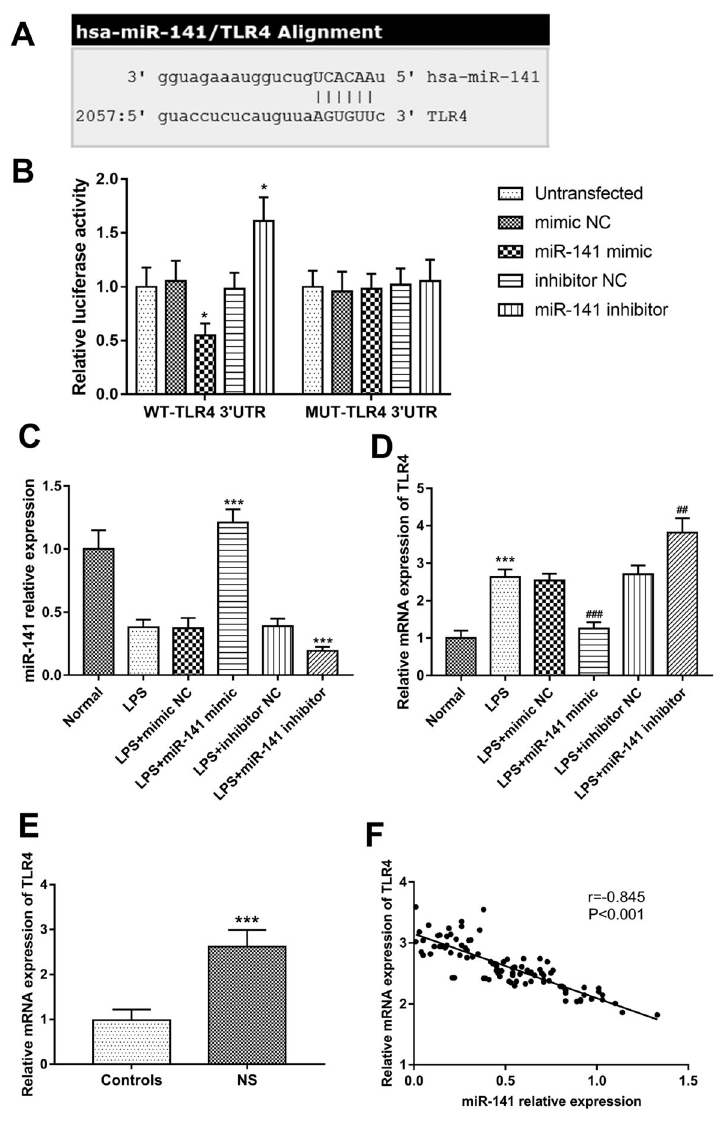
Figure 3. miR-141 directly regulated TLR4 in lipopolysaccharide (LPS)-treated monocytes. A , The putative binding site of miR-141 at the 3 0 -UTR of TLR4. B , The relative luciferase activity in the WT group was inhibited by the overexpression of miR-141, but was enhanced by the inhibition of miR-141 (WT: wild type; MUT: mutant type; *P o 0.05). C , The expression of miR-141 was successfully upregulated by miR-141 mimic, and was downregulated by miR-141 inhibitor (***P o 0.001). D , The promoted expression of TLR4 induced by LPS was inhibited by the overexpression of miR-141, but was further enhanced by the knockdown of miR-141 (***P o 0.001 compared with normal group; ## P o 0.01, ### P o 0.001 compared with LPS group). E , Serum relative mRNA expression of TLR4 was upregulated in septic neonates (NS) compared to that in control newborns (***P o 0.001). F , Serum levels of miR-141 were negatively correlated with levels of TLR4 (r= (cid:3) 0.845, P o 0.001). Data are reported as means ± SD (B , C , and D , ANOVA; E , t -test).